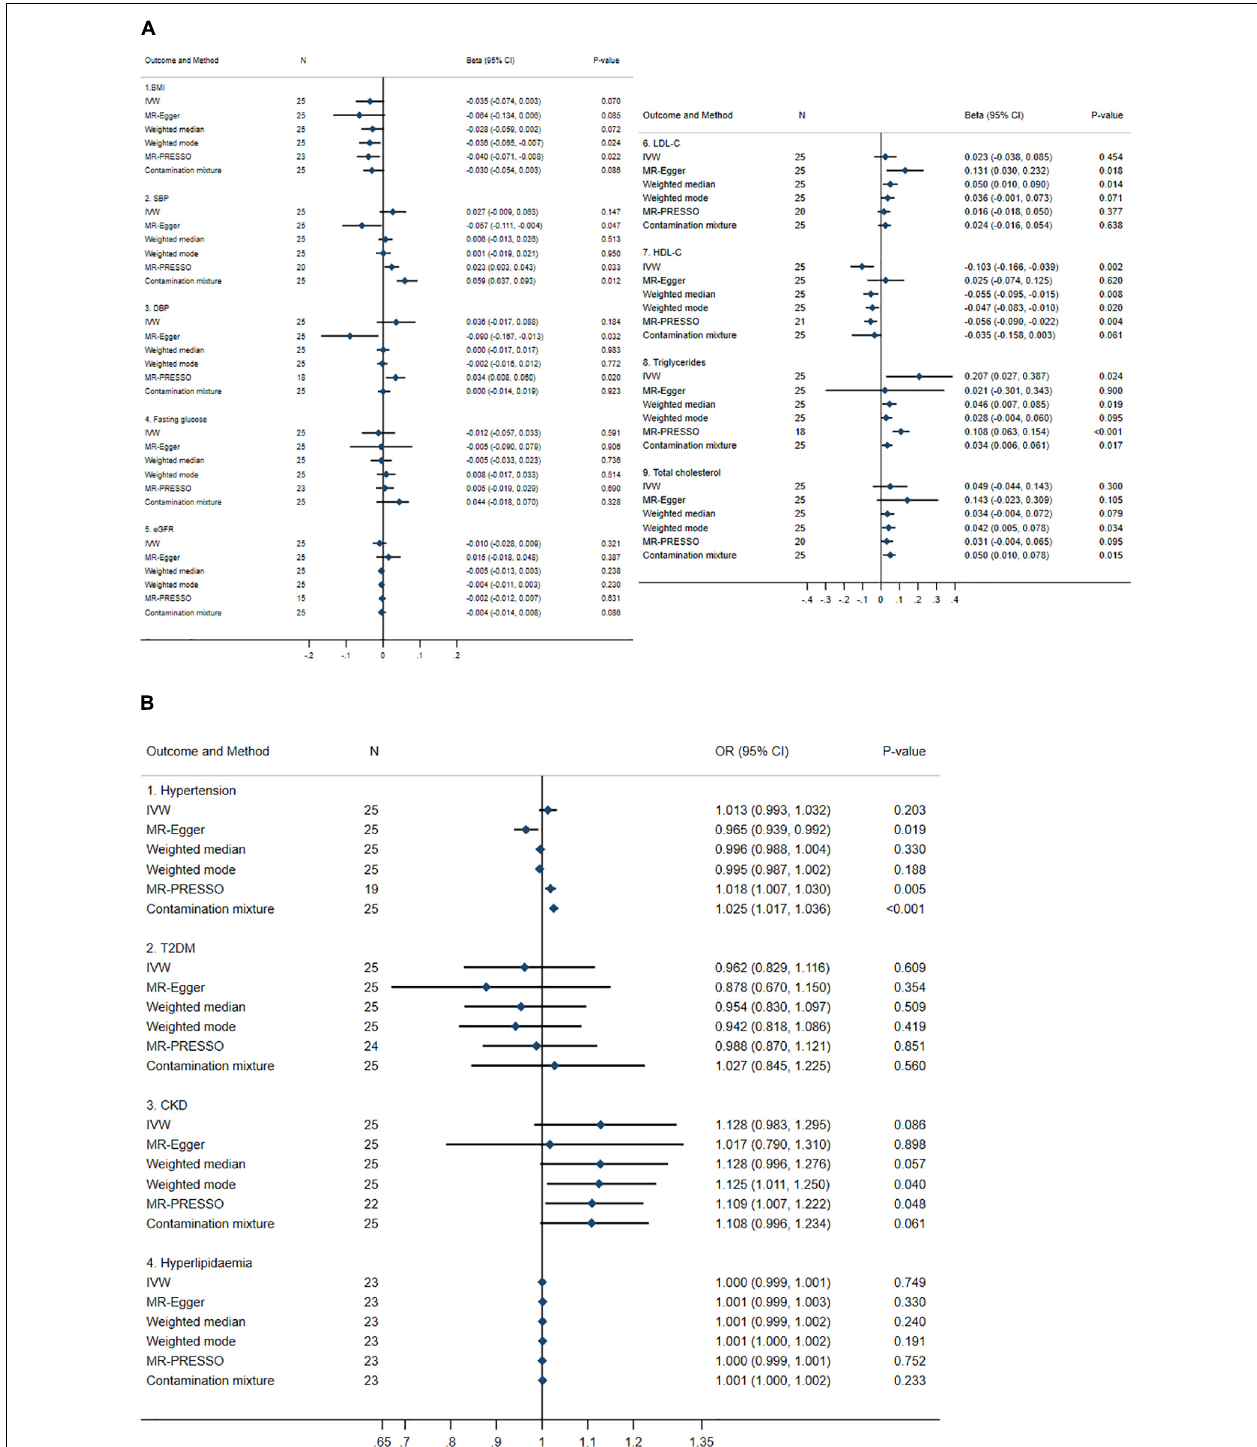
FIGURE 2 | Summary causal effects of genetically predicted urate on cardiovascular risk factors by a statistically driven approach. (A) Continuous outcomes. (B) Binary outcomes. Refer to the unit of continuous outcomes in Table 1 . Confidence interval (CI) from the contamination mixture method for LDL-C and T2DM contained multiple ranges of values (not shown in the figure). IVW, inverse variance weighted; MR-PRESSO, Mendelian Randomization Pleiotropy Residual Sum and Outlier; OR, odds ratio. For abbreviated outcomes, refer to abbreviation lists in Figure 1 .